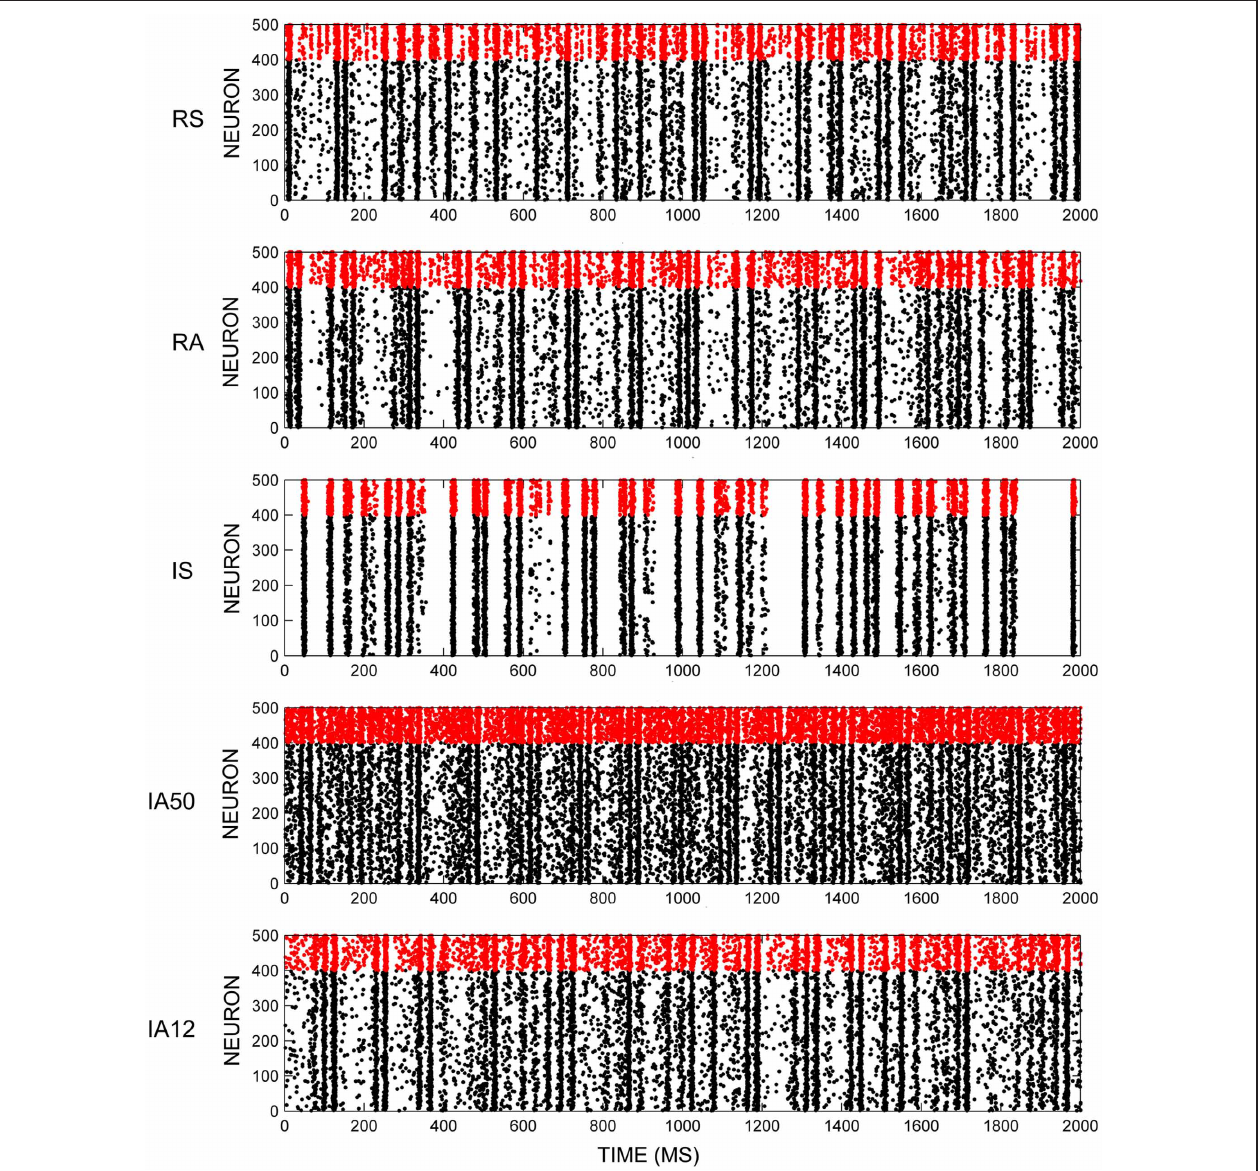
FIGURE 2 | Network firing activity. Exemplar rastergrams of 2s of network firing activity in response to different input regimes. All examples are from the same initial network. Red data points are FSI firings, black data points are RSE